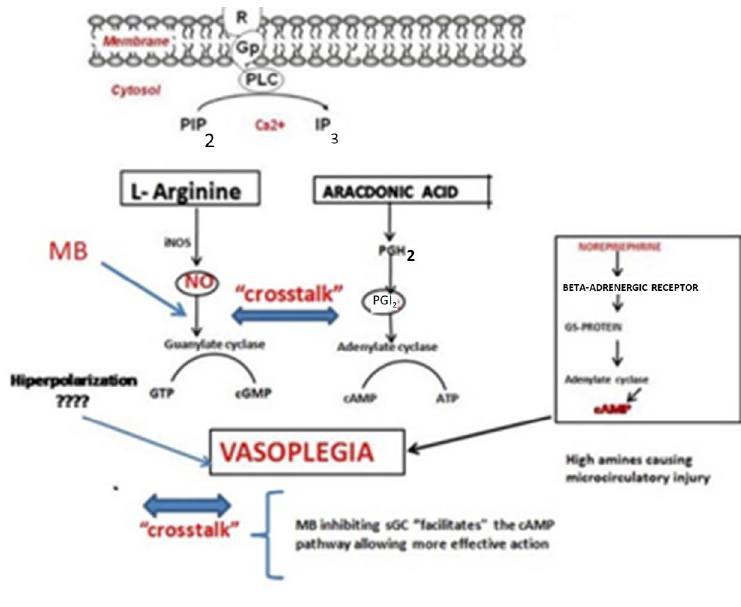
Fig. 4 – Schematic points of the “crosstalk” between cyclic guanosine monophosphate (cGMP) (nitric oxide [NO]) and 3’,5’-cyclic adenosine monophosphate (cAMP) (prostacyclin). ATP=adenosine triphosphate; Gp=Gp proteins; GS=Gs proteins; GTP=guanosine triphosphate; iNOS=inducible nitric oxide synthase; IP3=inositol triphosphate; MB=methylene blue; PGH2=prostaglandin H2; PGI2=prostacyclin; PIP2=phosphatidylinositol 4,5-biphosphate; PLC=phospholipase C; R=receptor; sGC=soluble guanylyl